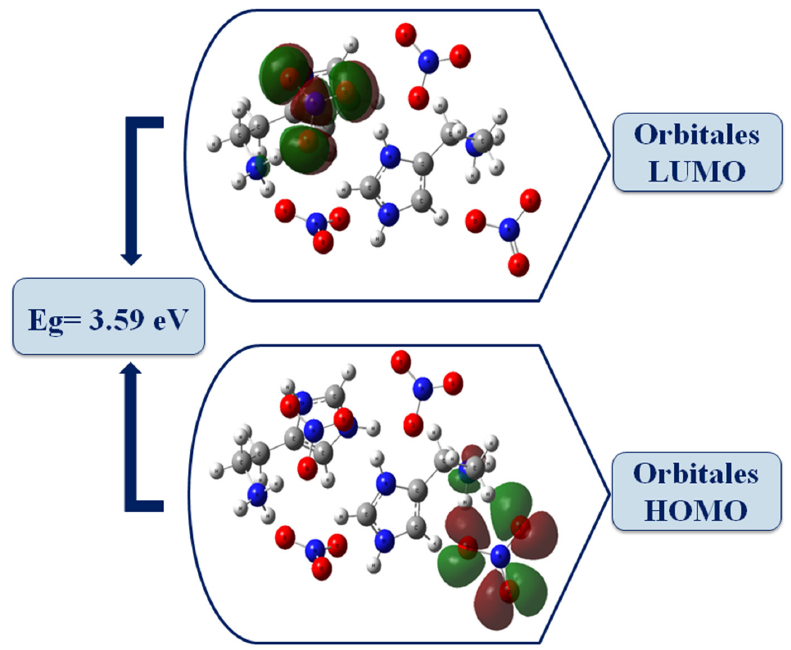
Figure 8. The molecular frontier orbitals of HTN computed using the B3LYP/LanL2DZ level. The comparison between the gap energy calculated for the HOMO, LUMO molecular boundaries (E g = 3.59 eV) with that evaluated by extrapolation in UV spectroscopy (E g = 3.80 eV) shows that the two methods give close energy values, which means that there is